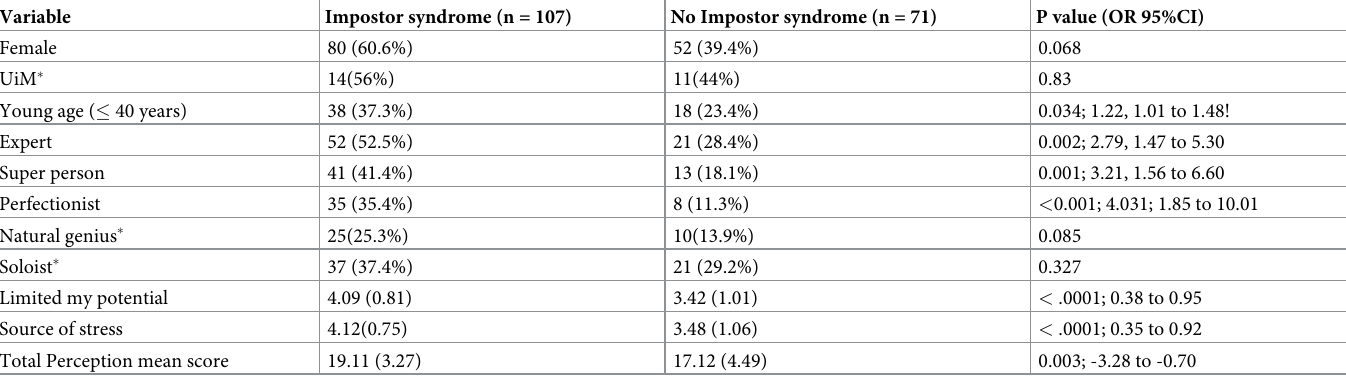
Table 2. Associations of participants who were identified with impostor syndrome versus those who were not.